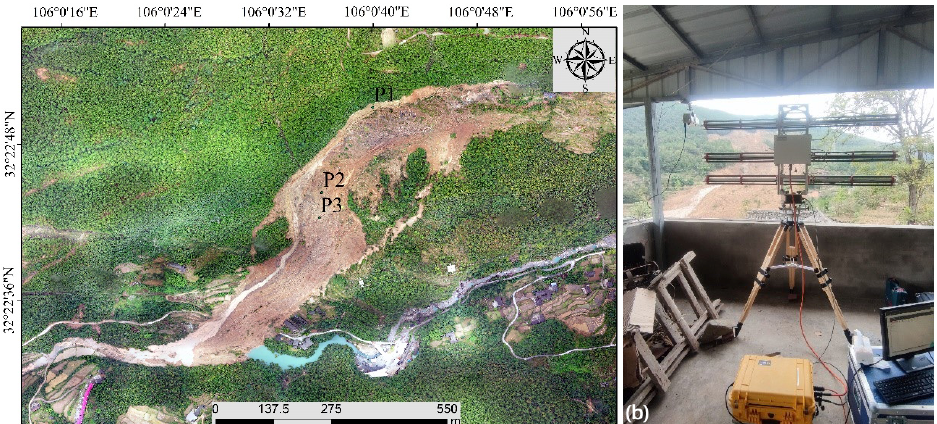
Figure 1. ( a ) is an orthophoto image processed by the DJI Royal 2 drone on 30 October 2021, showing the geographic location of the study area. P1, P2 and P3 are three study points selected from different locations of the landslide. P1 is the rear wall of the landslide, P2 is the landslide platform, and P3 is the secondary step. ( b ) is a photo of the GPRI-II equipment and the landslide mass.